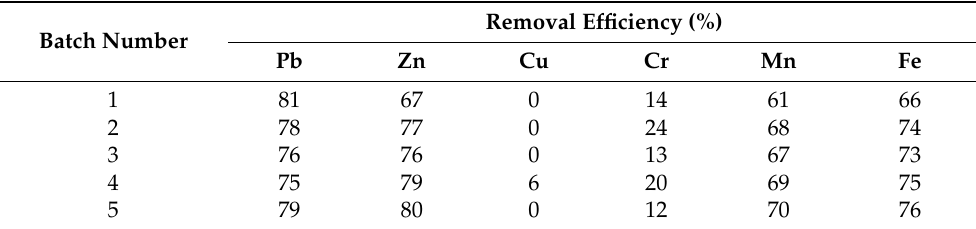
Table 2. The removal efficiency of metals from washed sewage sludge (SS) in a series of five consecutive